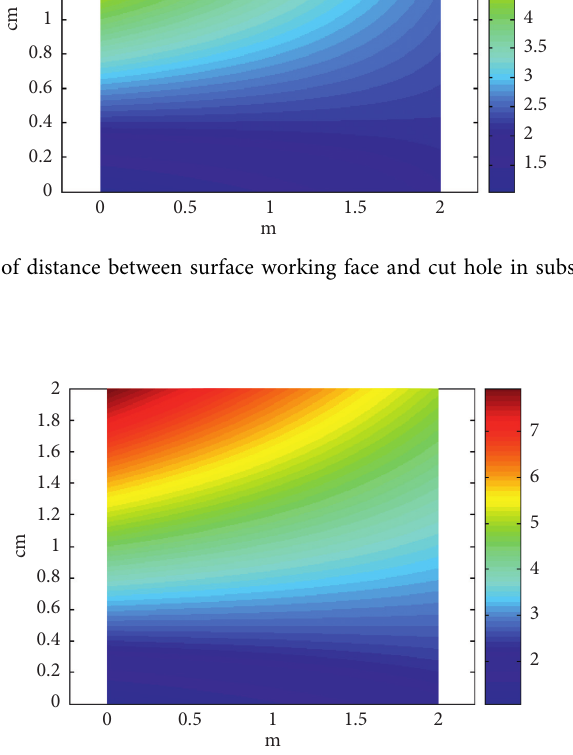
face and the cut is small, and the shape of the surface will change accordingly, resulting in cracks on the surface. The